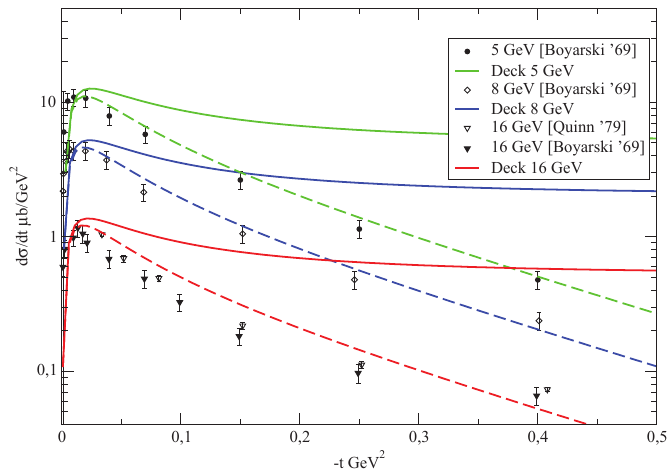
Figure 2. Unpolarised cross sections calculated at photon energies of 5, 8 and 16 GeV. Solid curves - one pion exchange model, dashed curves - one pion exchange model multiplied by Regge factor. (color online)